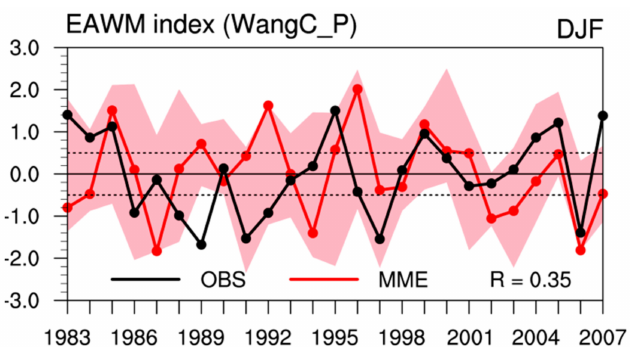
Figure 7. Interannual variation of the EAWM index for observations from NCEP-R2 (black line) and the ensemble means from the eight multi-models (red line). Dashed lines correspond to values of 0.5 and –0.5 std dev, respectively. Shading by pink denotes the range assessed from the individual model values used in